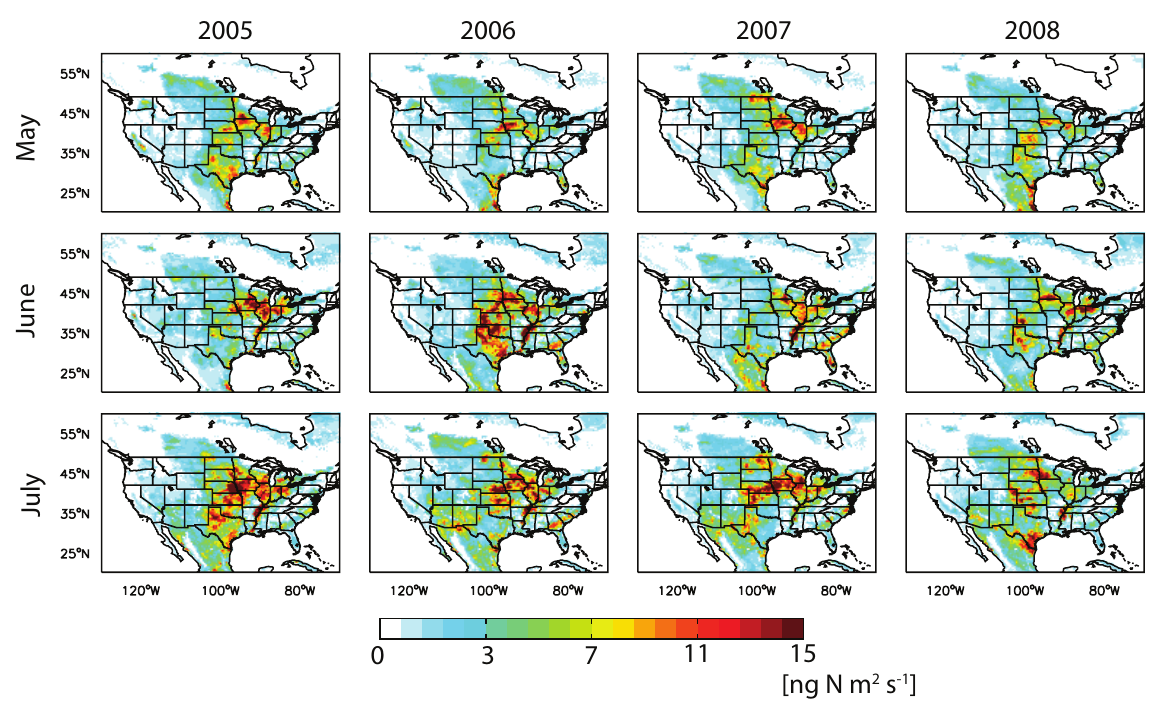
Fig. 1. Simulated monthly mean soil NO x emissions for 2005–2008 at 0.25 ◦ × 0.25 ◦ resolution. Emissions were derived using Yienger and Levy (1995) algorithm, with modifications as described in the text. The model is driven by daily precipitation and soil temperature from the North American Regional Reanalysis, NASA TERRA/MODIS HDF-EOS MOD12Q1 V004 land cover data, and fertilizer totals from Potter et al. (2010) with seasonality from Goebes et al. (2003) regridded to model resolution.